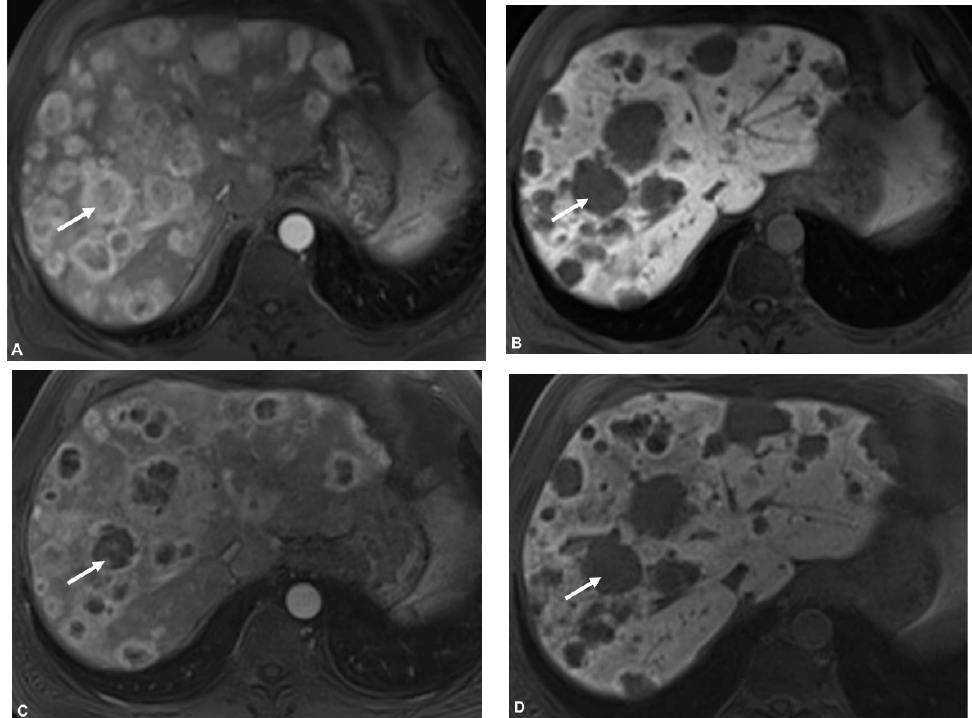
Figure 3. Patient with SD by RECIST vs. PR by mRECIST. On T1 weighted imaging on liver-specific phase the lesion showed low signal before ( B ) and after ( D ) TARE with not much change in size. However, there was an obvious decrease in arterial enhancement of the lesion pre- ( A ) and postinterventionally ( C ); therefore, the lesion was rated stable according to RECIST 1.1 criteria and as partial response according to mRECIST criteria.